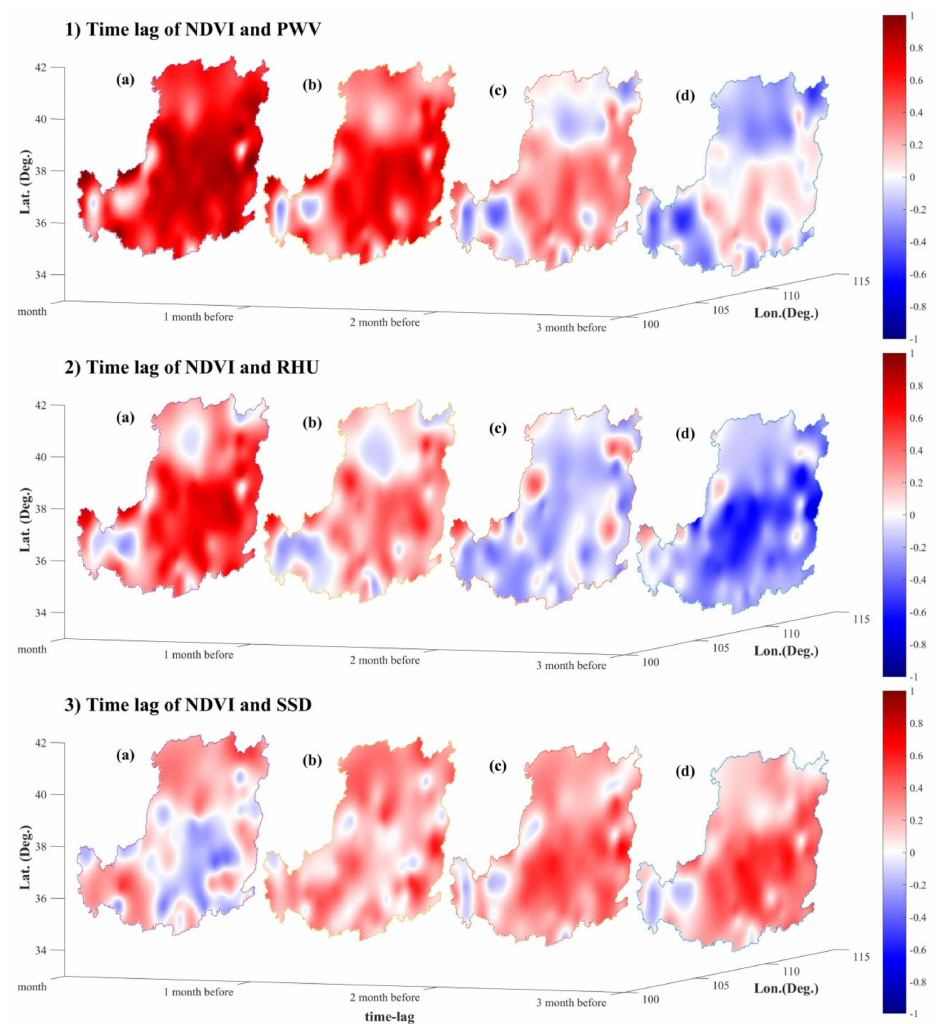
Figure 17. Spatial distribution of time delay impacts on vegetation growth associated with PWV, RHU, and SSD, where ( a )–( d ) refer to 0 month, 1 month before, 2 monthe before and 3 month before, respectively in the thee